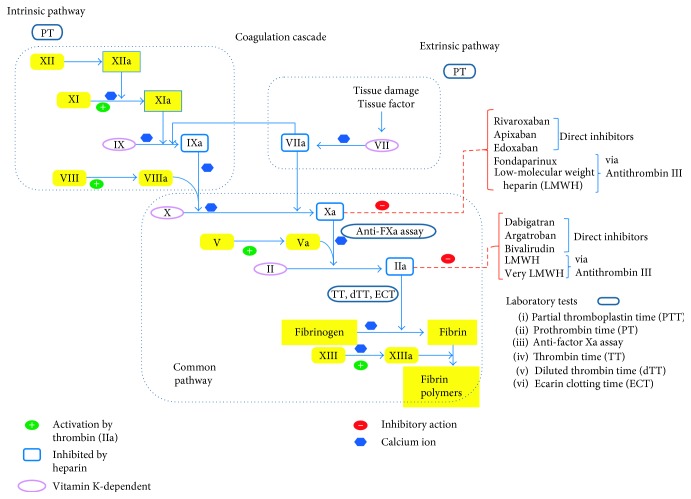
Coagulation cascade.